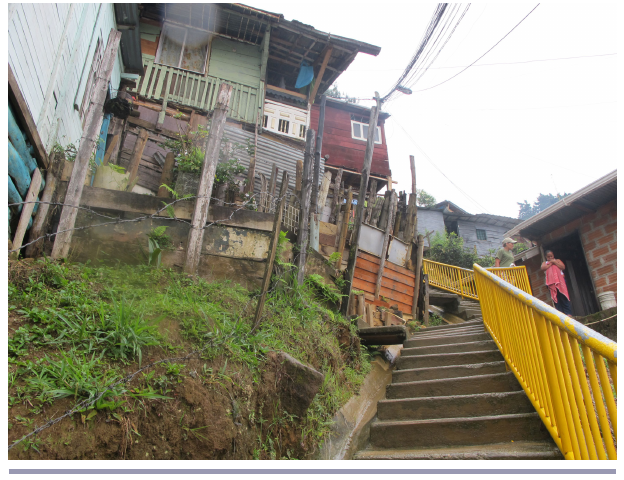
Fig. 3 . View of one of the access lanes in Pinares de